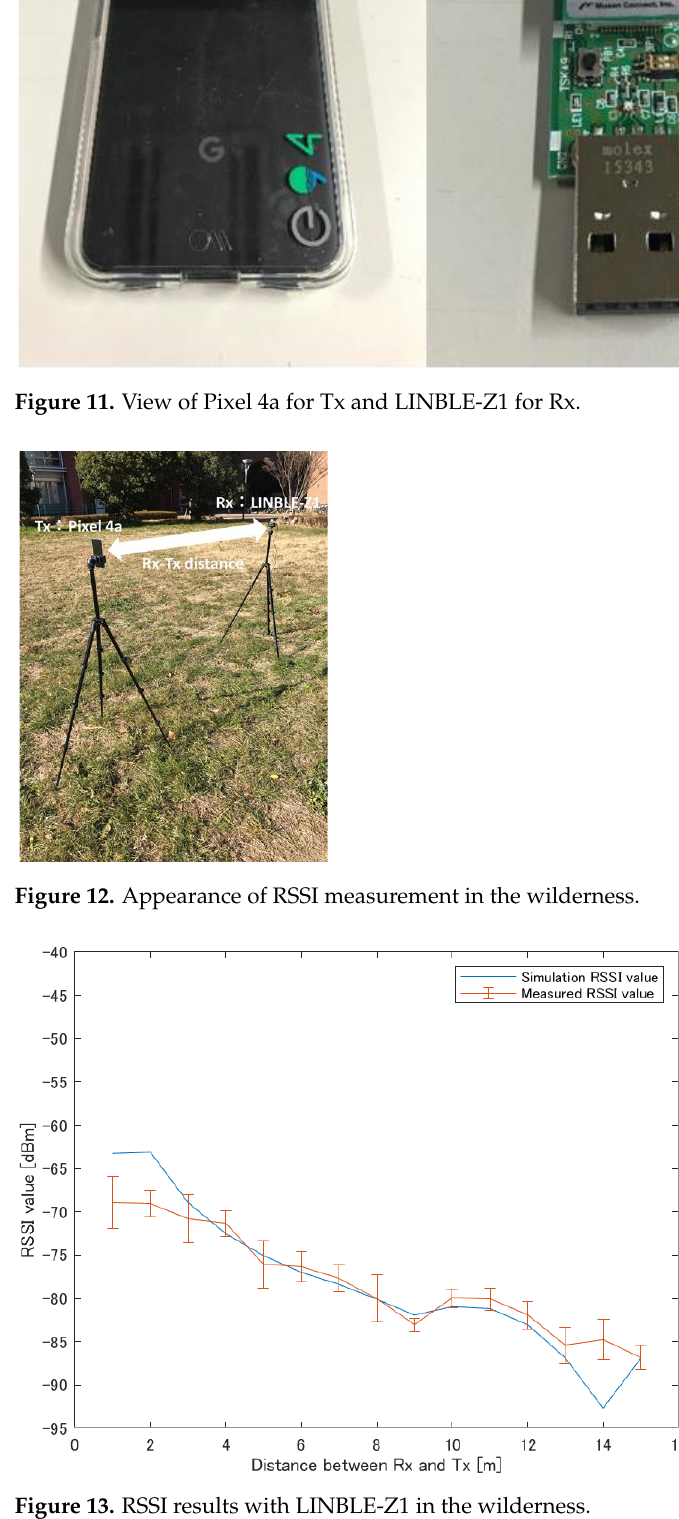
Figure 13. RSSI results with LINBLE-Z1 in the wilderness.